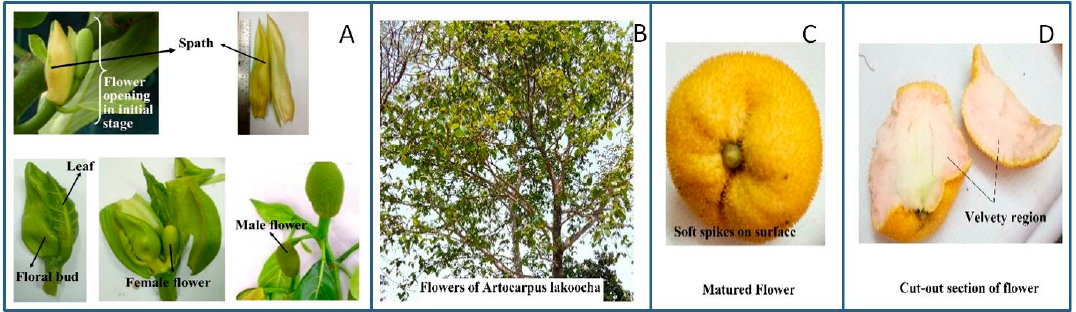
Figure 1. ( A ) Artocarpus heterophyllus Lam. flowers; ( B ) tree of Artocarpus lakoocha Roxb. with flowers; ( C ) upside view of Artocarpus lakoocha Roxb. flower; ( D ) cut ‐ out section of Artocarpus lakoocha flower.